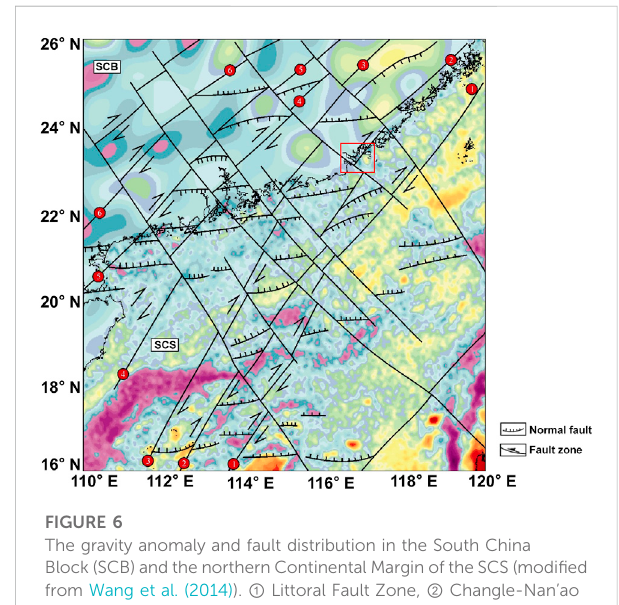
FIGURE 6 The gravity anomaly and fault distribution in the South China Block (SCB) and the northern Continental Margin of theSCS (modi fi ed from Wang et al. (2014)). ① Littoral Fault Zone, ② Changle-Nan ’ ao fault, ③ Zhenghe-Dabu Fault, ④ Shaowu-Heyuan-Yangjiang Fault, ⑤ Wuchuan-Sihui Fault, ⑥ Hepu-Beiliu Fault, red rectangle shows the major area of Lianjiang plain and its southeastern neritic area.